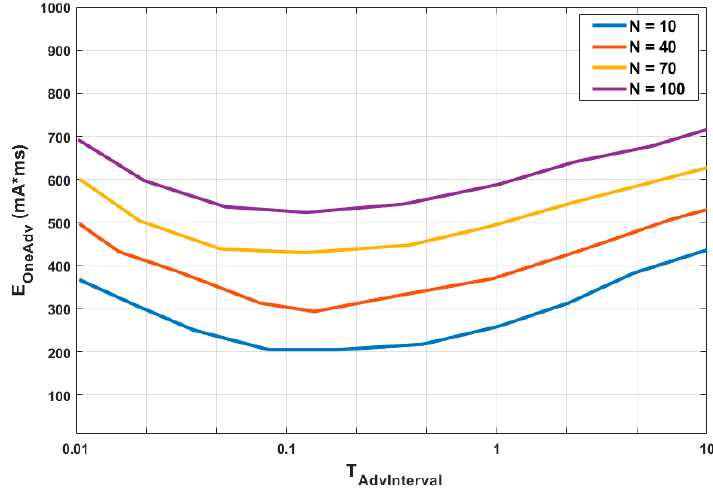
Figure 16. Energy consumption during advertisement event.